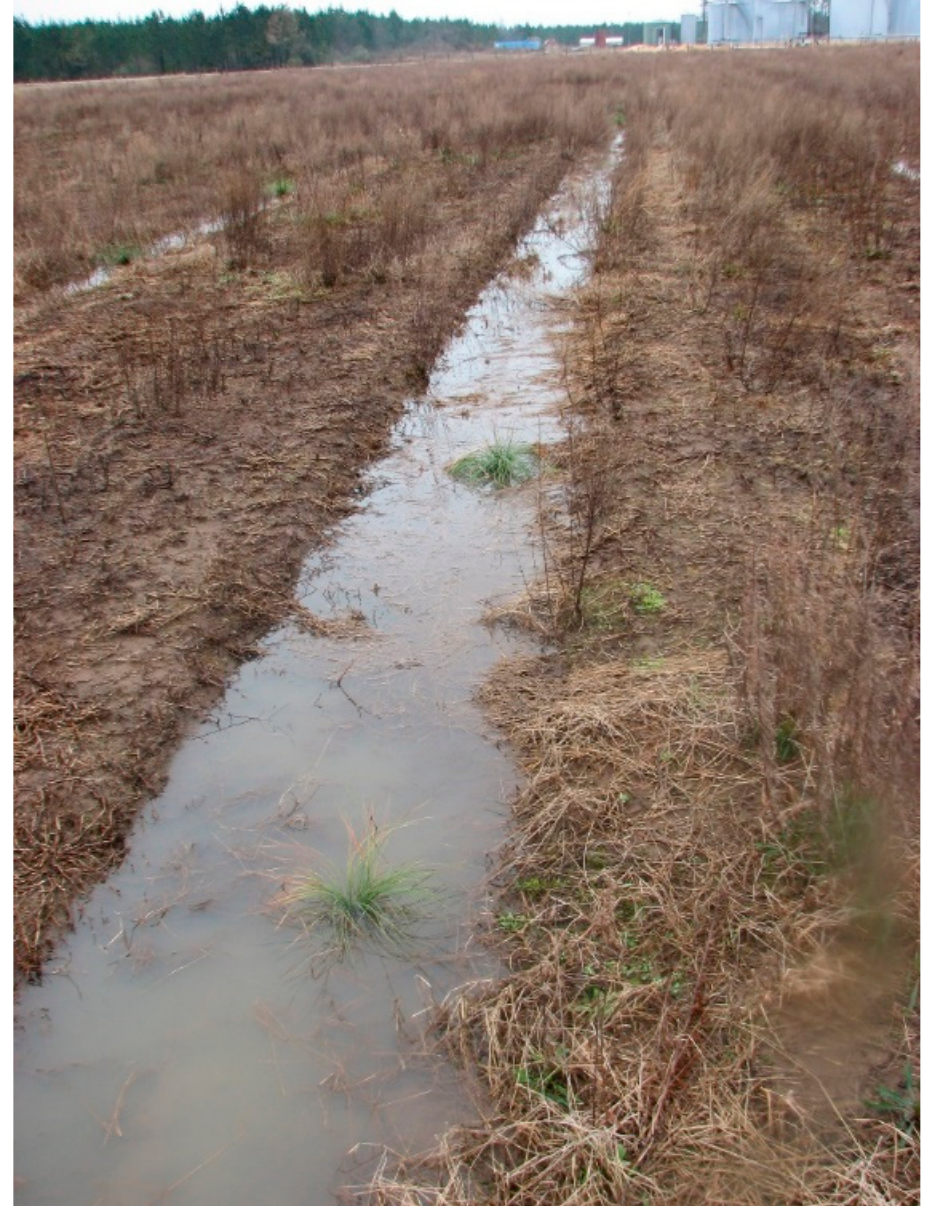
Figure 25. Scalping a fine-textured soil resulted in standing water which killed longleaf pine seedlings. Data from [68]. Seedlings were machine planted on 29 November 2007, and in April 2008, 243 mm of rain occurred over a 15-day period. A year later, March rain occurred on the 4th (41.1 mm), 7th (81.5 mm) and 12th (4.3 mm) and the photo was taken 13 March 2008. Scalping increased the mortality of bareroot stock (73% and 91% survival on scalped and non-scalped areas,